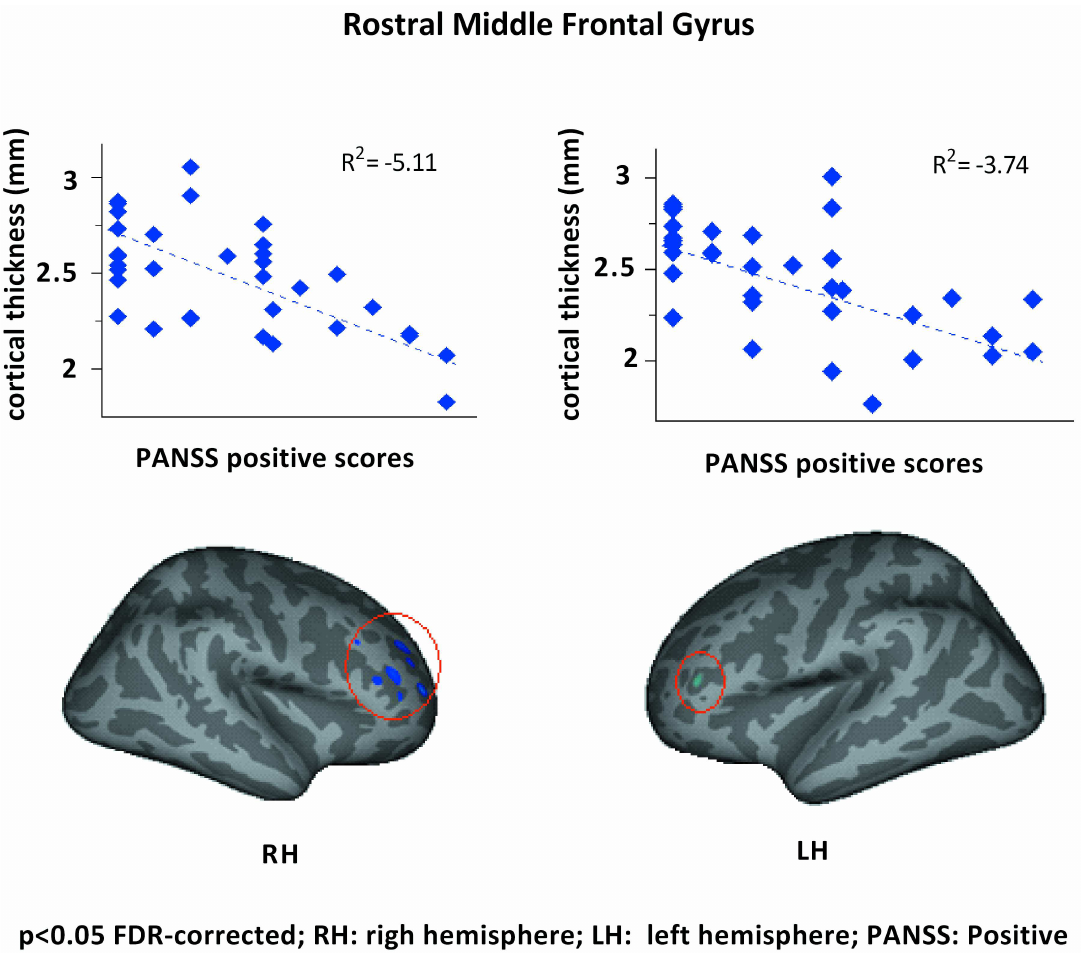
Fig 3. Bilateral thinner rostral middle frontal gyrus CT was associated with increased positive symptoms severity in both UHR subjects (n = 18) and matched 22q11DS (n = 18) subjects. Findings were corrected for differences in brain segmentation volume, age and gender. See S1 and S2